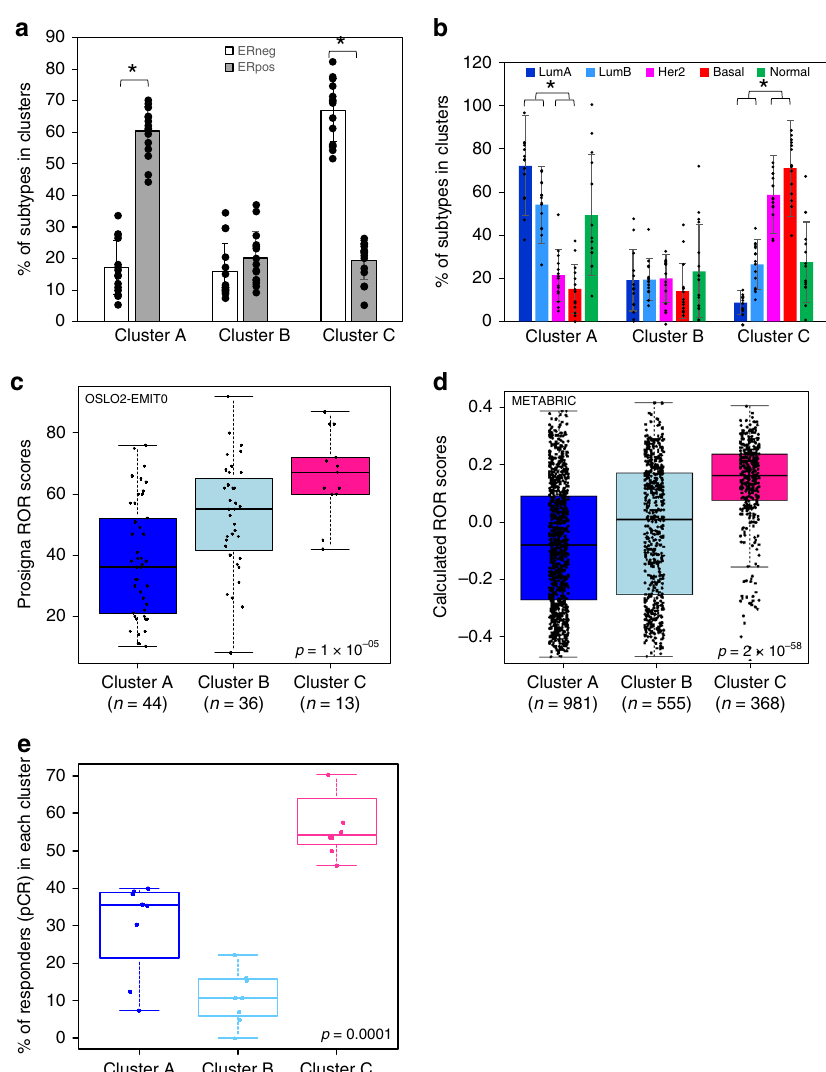
Fig. 4 Immune clusters and clinicopathological features. a , b Average percentage of ER-positive and ER-negative samples ( a ) or PAM50 subtypes ( b ) of 15 cohorts across the clusters. Cluster A is enriched for ER-positive, Luminal A, Luminal B samples while a signi fi cantly higher percentage of ER-negative, Basal-like, Her2-enriched samples was found in Cluster C (high in fi ltration). Asterisk (*) denote t test p value < 0.0001. Error bars represent standard error to the mean. c Prosigna Breast Cancer ROR scores for the OSLO2-EMIT0 cohort were obtained from the NanoString nCounter Dx Analysis System using FFPE breast tumor tissue. Boxplots represent the average Prosigna ROR scores in the immune clusters. Kruskal – Wallis test p value is denoted. d Calculated ROR scores following the method of Parker et al. 3 are compared to immune clusters using boxplots in the METABRIC cohort. Kruskal – Wallis test p values is shown. e From eight breast cancer cohorts, in which the pathological complete response (pCR) was assessed after administration of neoadjuvant chemotherapy, we calculated the percentage of responders in each cluster. Boxplots show the distribution of the percentage of responders in each immune cluster. Kruskal – Wallis test p value is denoted. The line within each box represents the median. Upper and lower edges of each box represent 75th and 25th percentiles, respectively. The whiskers represent the lowest datum still within [1.5 × (75th − 25th percentile)] of the lower quartile and the highest datum still within [1.5 × (75th − 25th percentile)] of the upper Validation in a new RNA-seq dataset with risk of recurrence This observation was also true when assessing the ER-negative (ROR) scores . We generated a new dataset: EMIT0, which is a (Supplementary Fig. 7A) and ER-positive (Supplementary Fig. 7B) cases separately. For all cohorts, we calculated the ROR subset of the OSLO2 cohort study. The OSLO2-EMIT0 was scores following Parker et al. 3 ’ s method, which is related to assessed by the Food and Drug Administration-approved Pro- PAM50 subtyping 3 , and con fi rmed that Cluster B was composed signa risk of recurence (ROR) scores. As recently demonstrated, of intermediate ROR scores as exempli fi ed in the METABRIC ROR scores add signi fi cant prognostic information above stan- cohort (Fig. 4d and Supplementary Fig. 7C, D). dard clinicopathological features 3,27 . We assessed whether the immune clusters could add prognostic value to ROR scores. We Multivariable regression analysis con fi rmed that the immune found Cluster B composed of samples with intermediate ROR clusters bring additional prognostic value to the ROR scores scores compared to Clusters A and C (Fig. 4c). This suggested (Supplementary Table 6) as demonstrated by the signi fi cant that the poor prognosis associated with Cluster B was not likely to p values for the immune clusters when modeling survival with be explained by the information contained in the ROR scores. ROR scores and immune clusters. Through computation of net